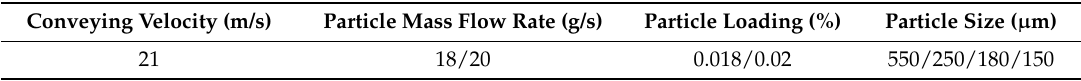
Table 2. Additional experiment conditions for validation.